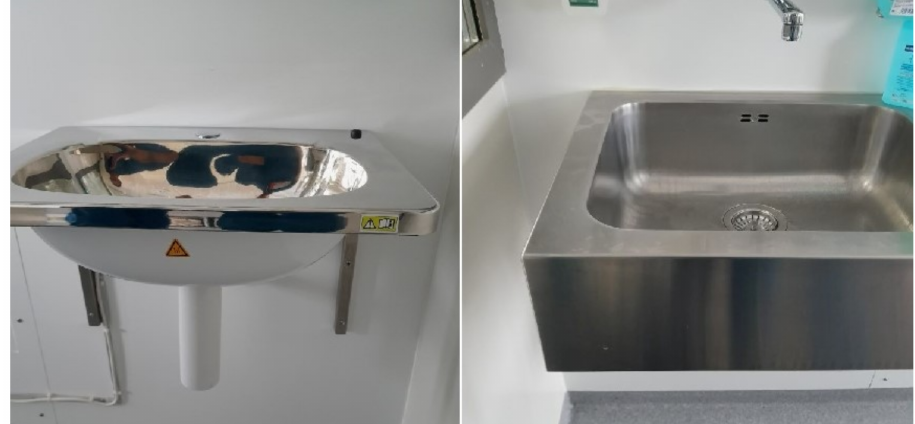
Figure 1. The self-disinfecting sink installed in room 1 is shown to the left, whereas the regular sink used in all of the other rooms in the Burn Centre is shown to the